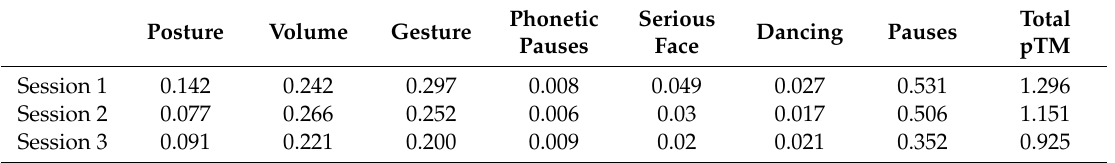
Table 1. Mean (M) of the pTM (0 to 1) of participants for the 3 practice sessions. Posture Volume Gesture